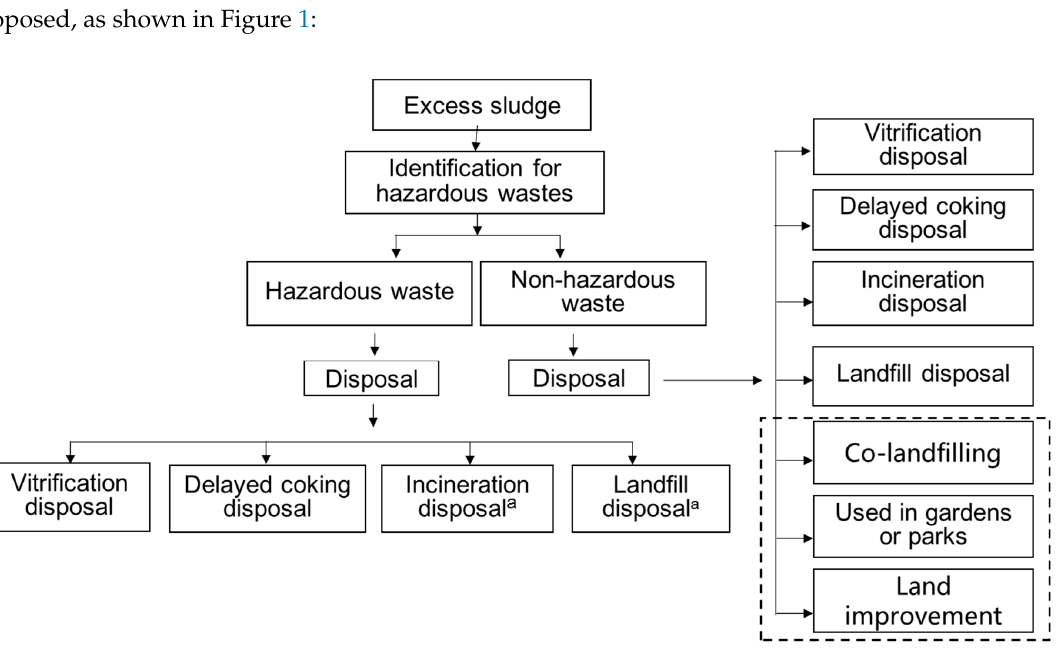
Figure 1. Flow chart of the classification and disposal strategy for petrochemical excess sludge. ( a Meets the corresponding disposal requirements for hazardous waste.)